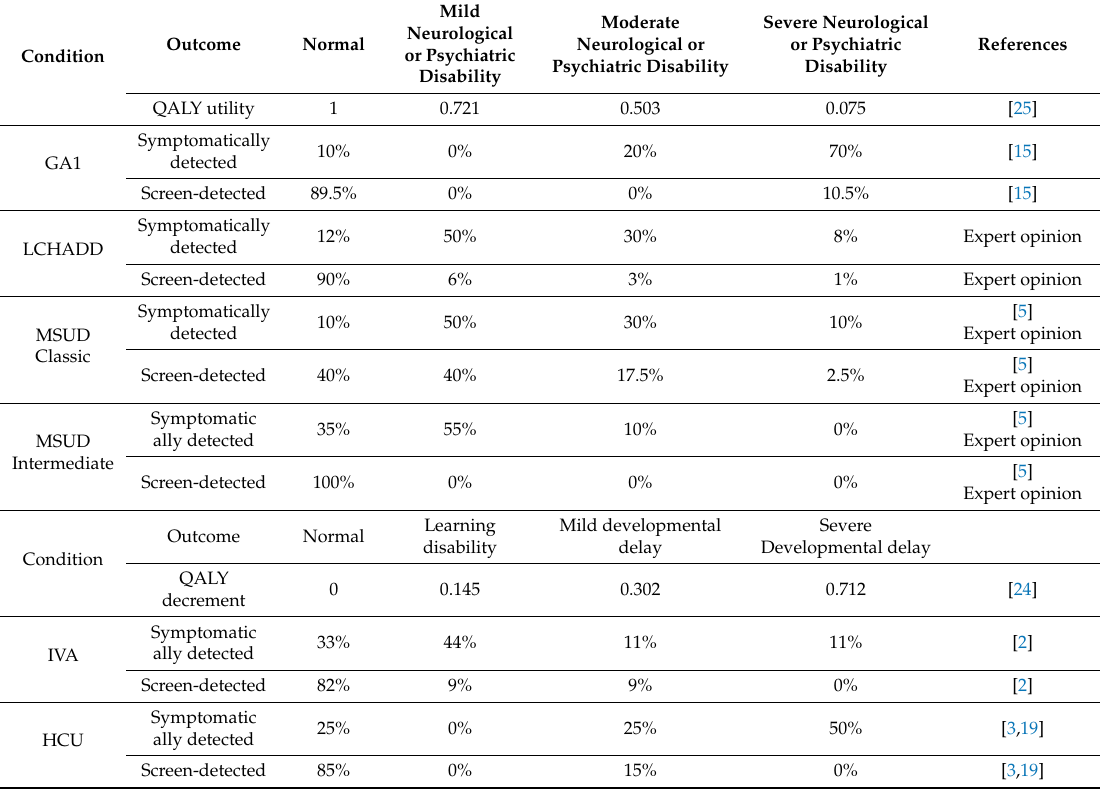
Table 2. Morbidity distribution for each condition and quality-of-life